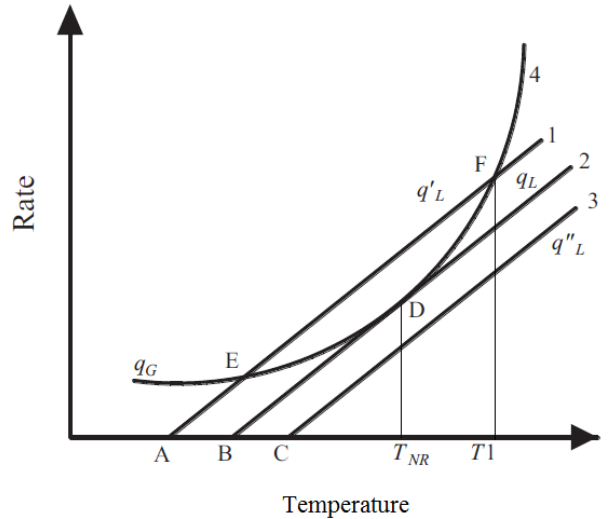
Figure 12. Semenov plot depicting heat generation and loss from a system. Reproduced with permission from ref. [142]. Copyright 2012. Elsevier B.V.